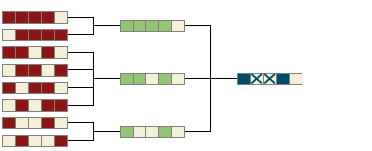
Fig. 9 Color-coding of Walsh coef fi cients for a system of fi ve-transmon qubits. The fi rst column shows the individual qubit assignments (light color = “ 0 ” , red color = “ 1 ” ), and the second and third columns indicate ways to average coef fi cients according to the enclosing